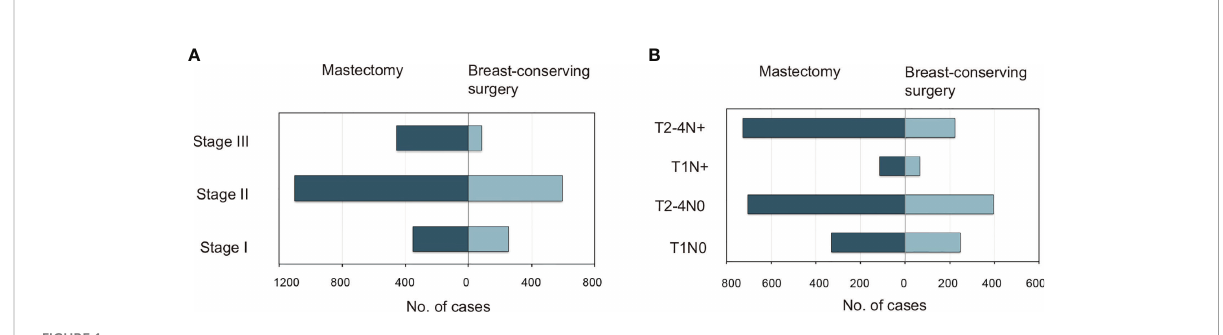
FIGURE 1 Distributions of patients <40 years with triple-negative breast cancer who underwent mastectomy versus breast-conserving surgery as categorized by (A) AJCC stage and (B) speci fi c T and N substages. AJCC, American Joint Committee on